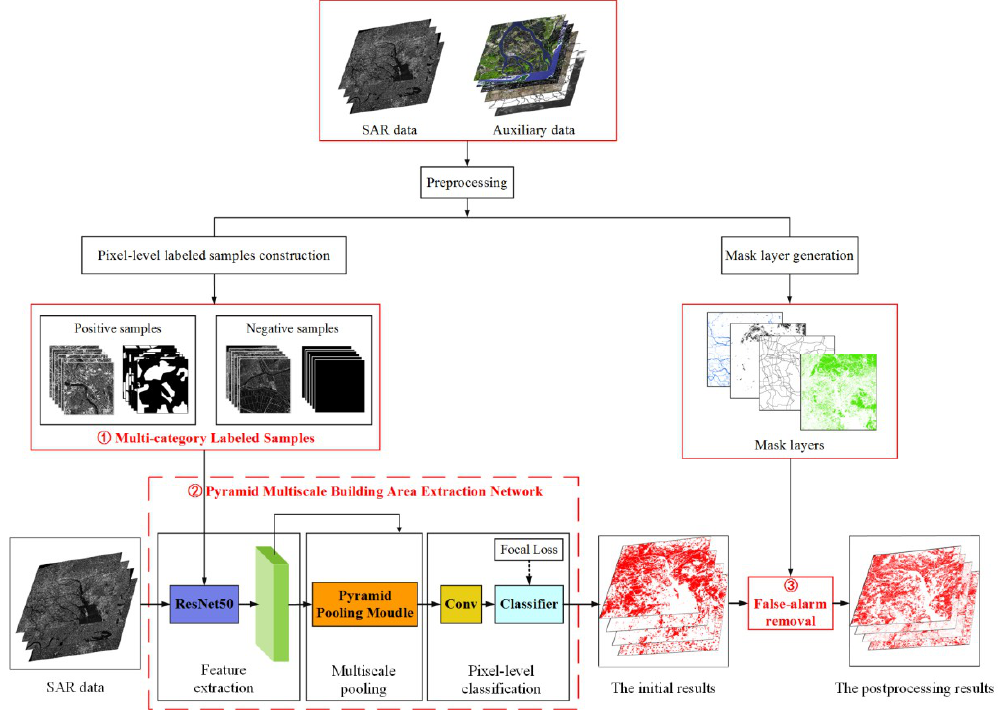
Figure 1. Flowchart of building-area extraction using synthetic aperture radar (SAR) data.